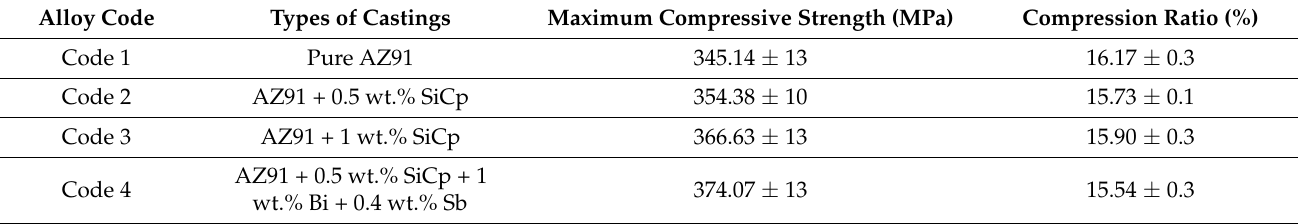
Figure 6. Charpy impact test and absorbed impact energy of pure and modified AZ91 alloys.